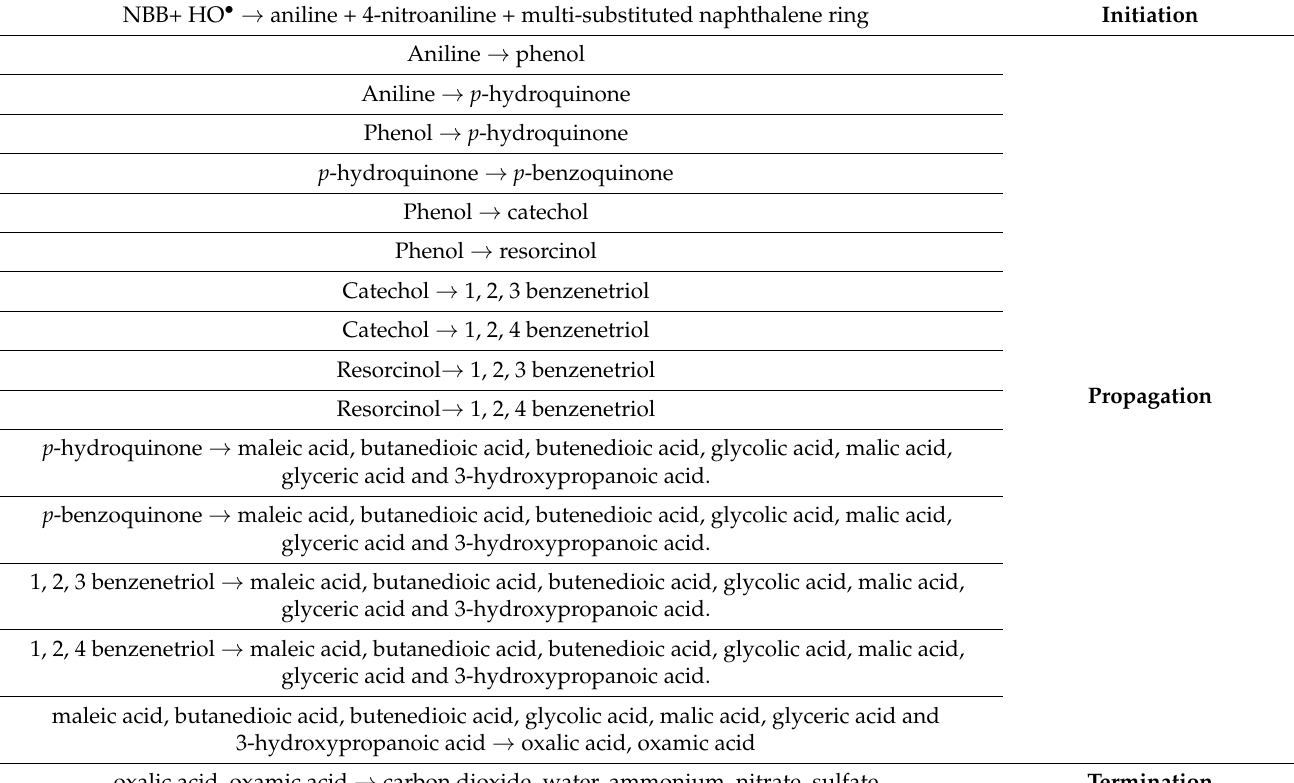
Table 2. Detailed chain mechanism of oxidation of naphthol blue black initiated by hydroxyl radical attack